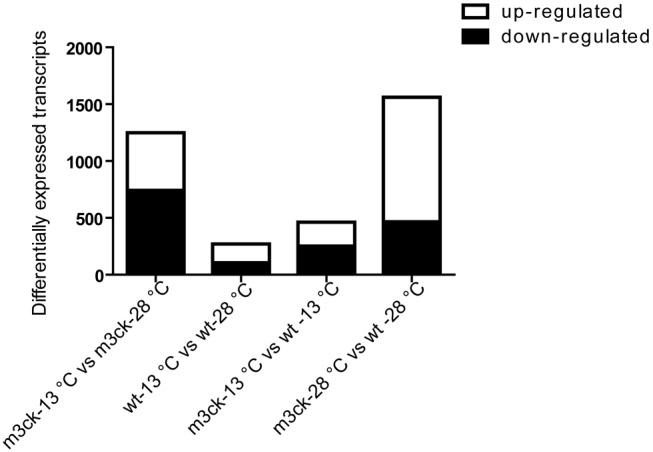
Relative abundance of up- and down-regulated transcripts in the experimental groups.The numbers of differentially expressed genes are shown. Transcripts with fold change ≥2, P value <0.05, were considered to be differentially expressed.